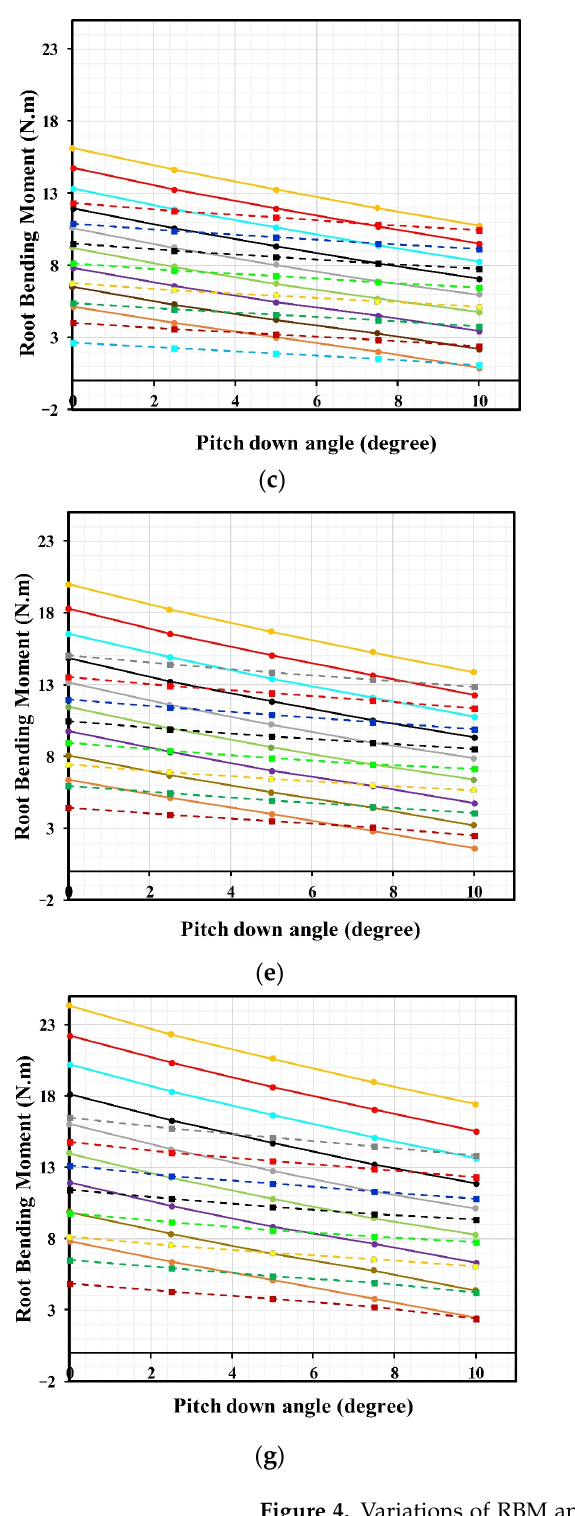
Figure 4. Variations of RBM and C D at different span extensions: ( a ) RBM vs. pitch down angle at 0% span extension. ( b ) C D vs. pitch down angle at 0% span extension. ( c ) RBM vs. pitch down angle at 25% span extension. ( d ) C D vs. pitch down angle at 25% span extension. ( e ) RBM vs. pitch down angle at 37.5% span extension. ( f ) C D vs. pitch down angle at 37.5% span extension. ( g ) RBM vs. pitch down angle at 50% span extension. ( h ) C D vs. pitch down angle at 50% span extension. Reprinted/adapted with permission from Ref. [30]. 2021, American Institute of Aeronautics and Astronautics, Inc.